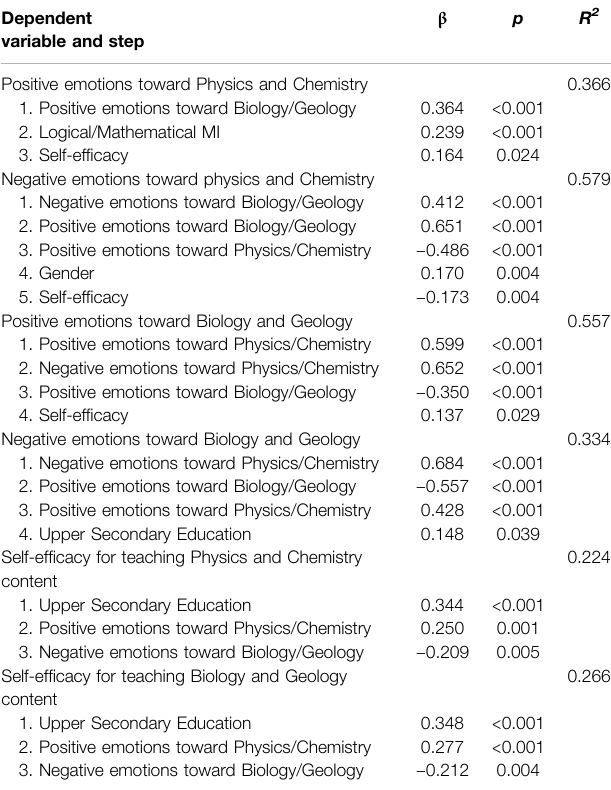
TABLE 5 | Multiple regression analyses (stepwise method): the predictor variables. Dependent variable and